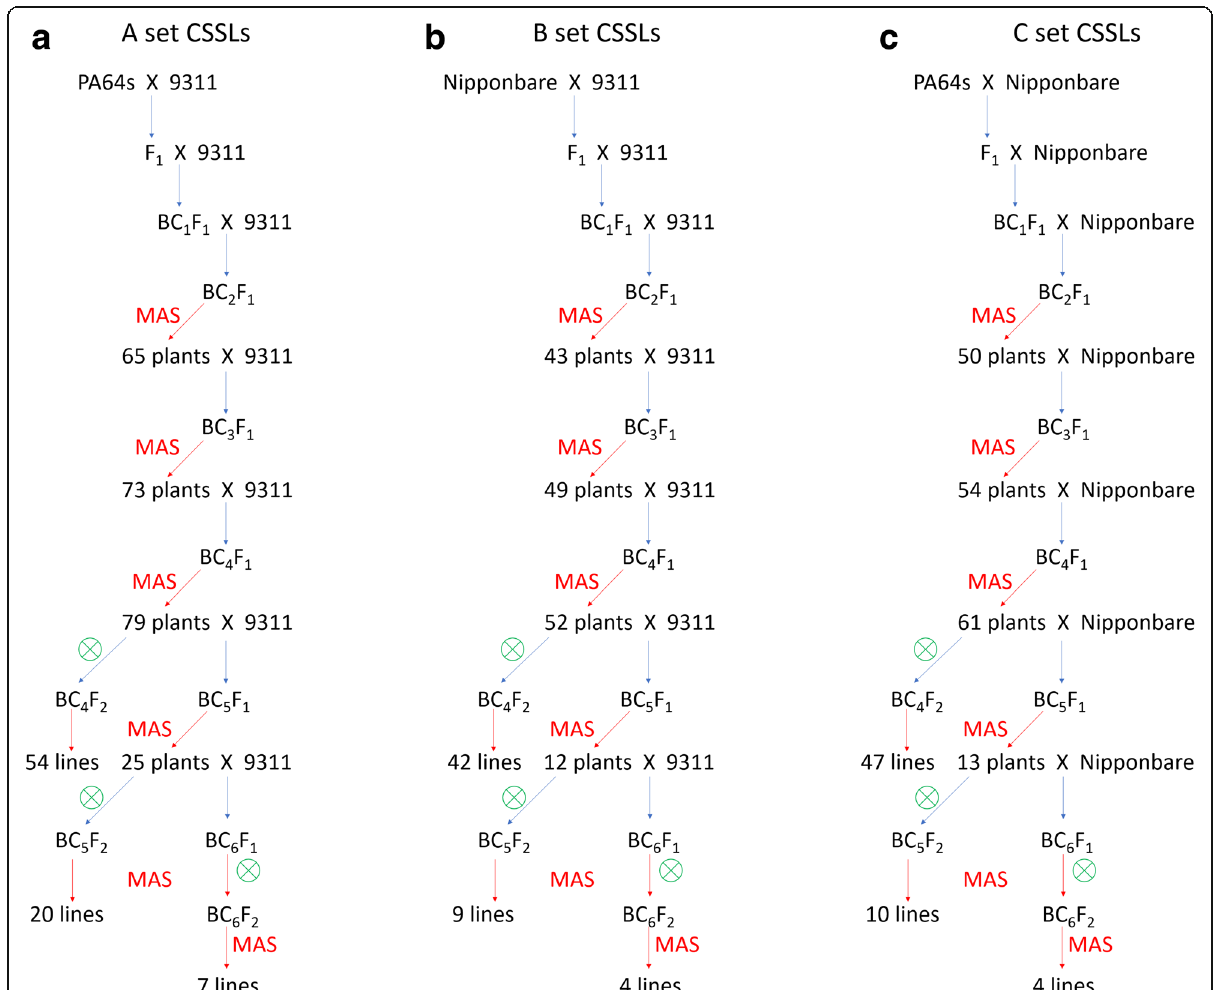
Fig. 1 Flowchart of the procession of developing 3 sets of CSSLs. a Precession of developing A set CSSLs. b Precession of developing B set CSSLs. c Precession of developing C set CSSLs. The female parent is written in the front and the male parent in the back in hybrid combinations. The red arrow indicates that the genotypes of plants were identified by MAS. Numbers under the red arrow represent the selected individuals of lines by MAS. The green circle represents a